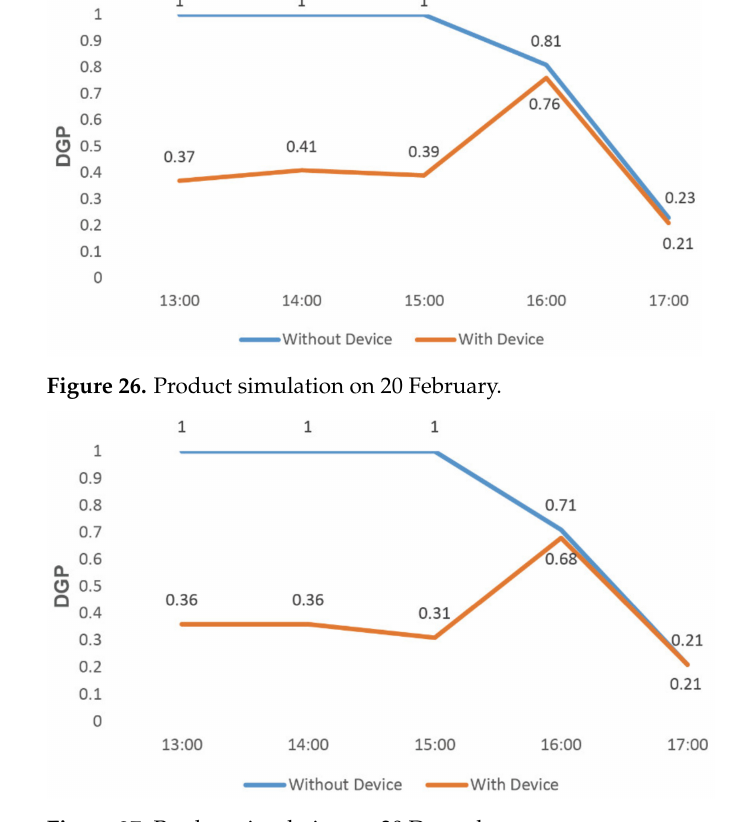
Figure 27. Product simulation on 30